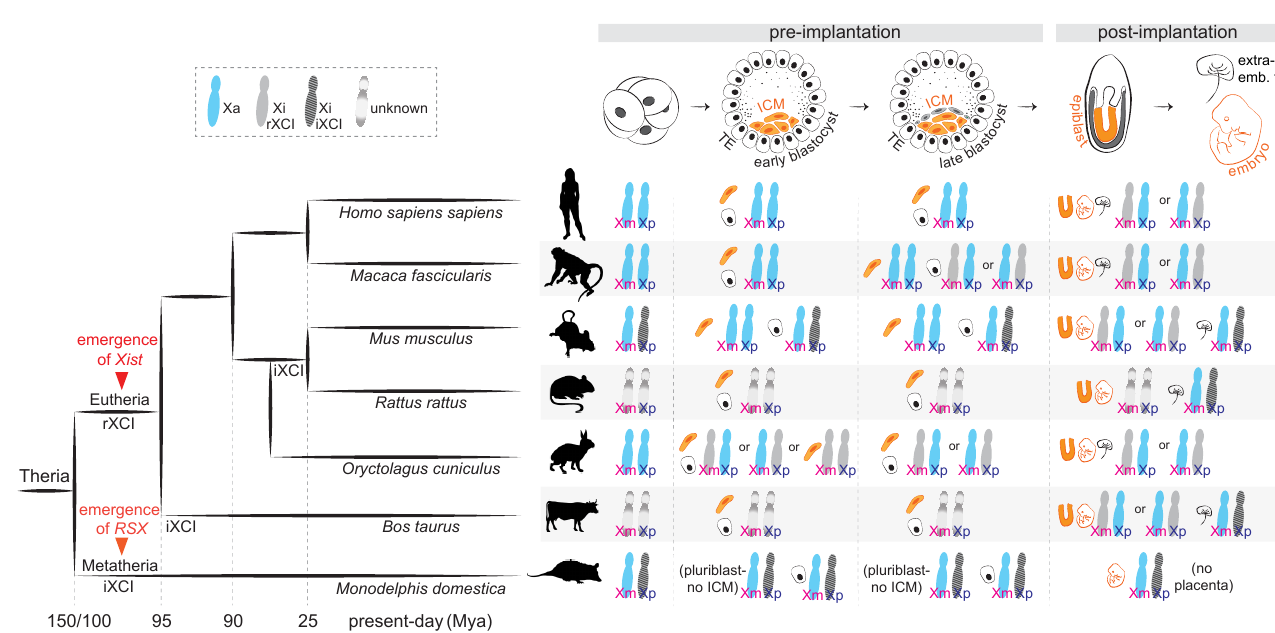
Figure 1. X-chromosome inactivation across species. Left : a phylogenetic tree indicating the evolution of random and imprinted XCI and the emergence of long non-coding RNAs Xist and RSX in Theria. Right : X-chromosome inactivation dynamics across development in representative